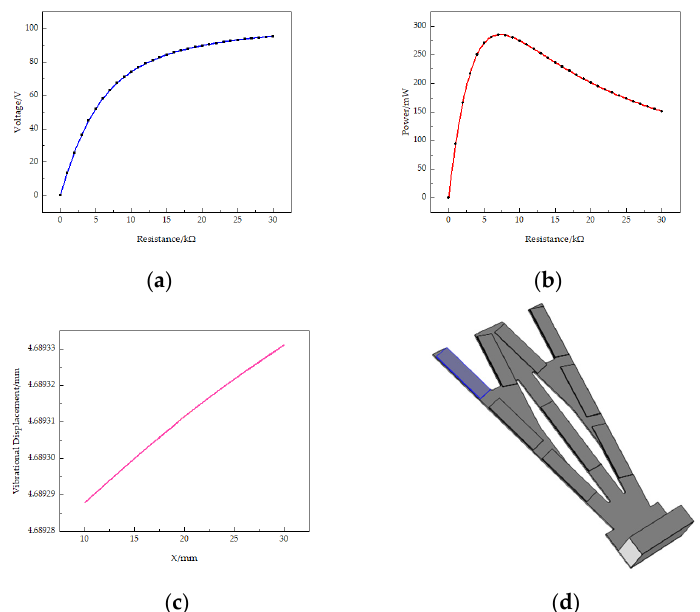
Figure 4. ( a ) Output voltage of the STTM-PEH with varying resistance; ( b ) output power of the STTM-PEH with varying resistance; ( c ) the vibrational displacement of each point at the tip of the beam; ( d ) the installation position of the piezoelectric patch with maximum stress on the T-shaped trapezoidal piezoelectric cantilever beam.